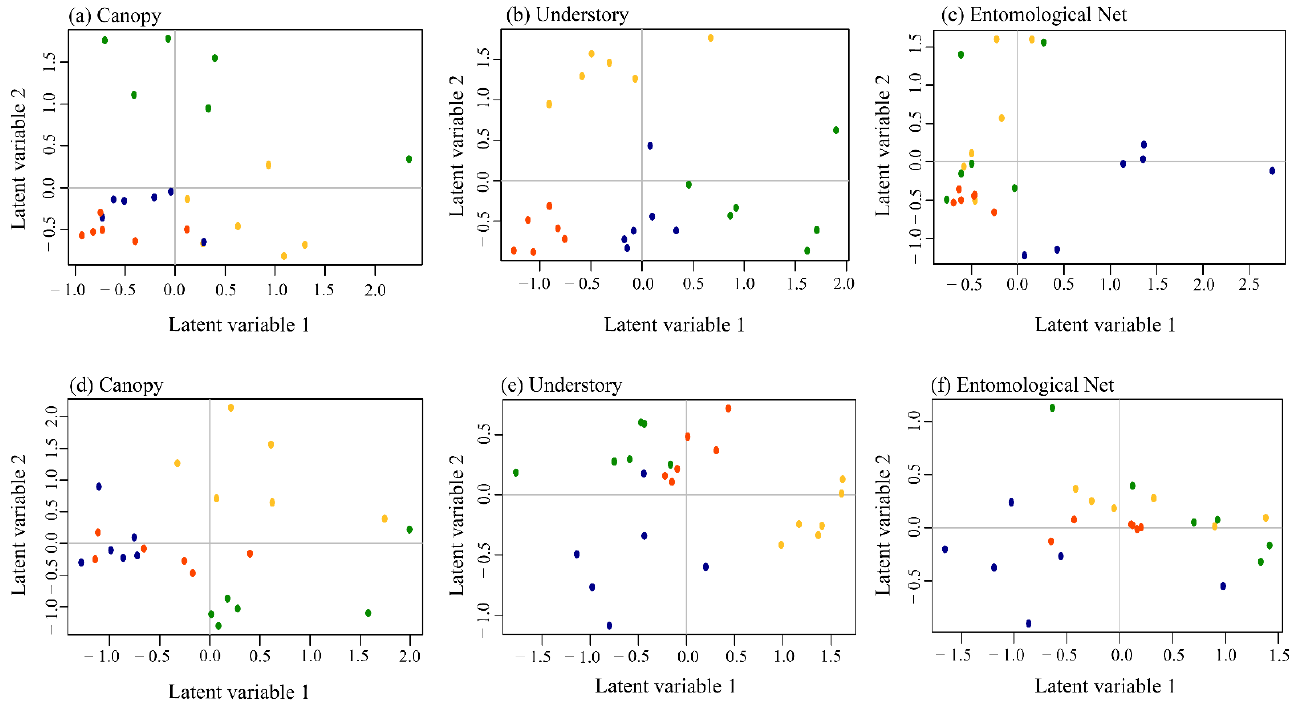
Figure 3. EcoCopula ordination based on occurrence ( a – c ) and abundance data ( d – f) of butterfly species before (Pre = green), immediately after (PostIm = red), one year after (Post1 = yellow) and two years after (Post2 = blue) the creation of the Santo Antônio dam on the Madeira River in southwestern Amazonia, Brazil. Latent variables (unobserved environmental gradients) are shown for three different sampling techniques: canopy, understory, and entomological nets. The dots represent distances from the river 0, 500, 1000, 2000, 3000, and 4000 m.